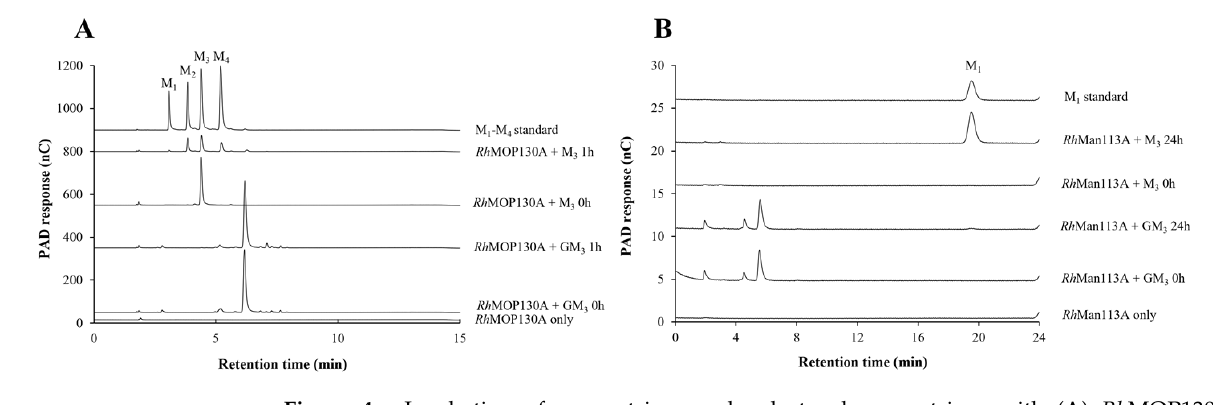
Table 2. Specific activity and enzyme kinetic parameters of Rh Man113A, using different substrates. Rh Man113A